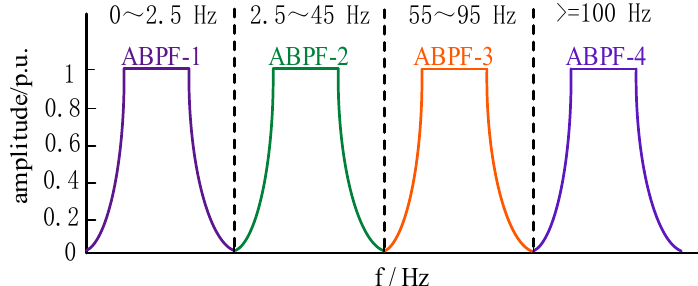
Figure 3. Four-band ABPF cascade.